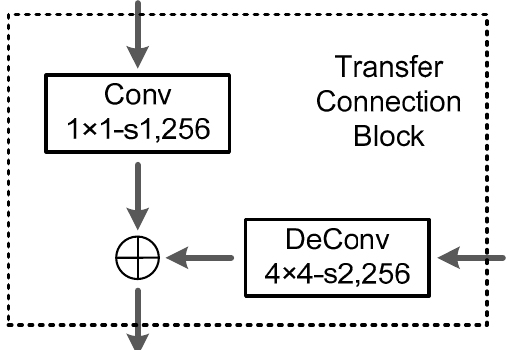
Figure 3. The overview of the transfer connection block.